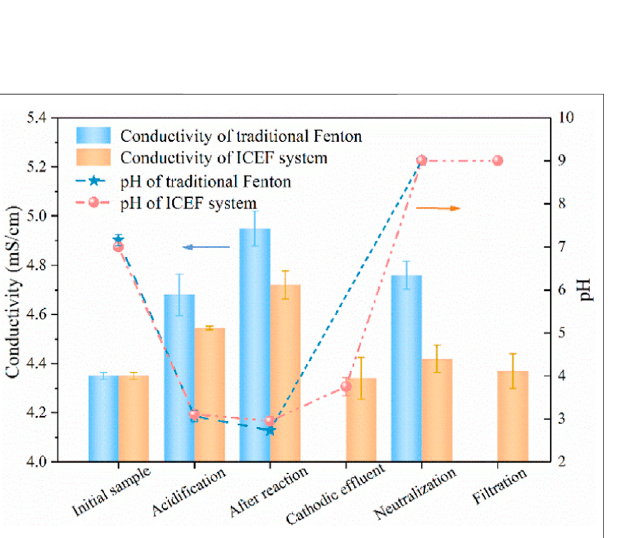
Frontiers in Chemistry |